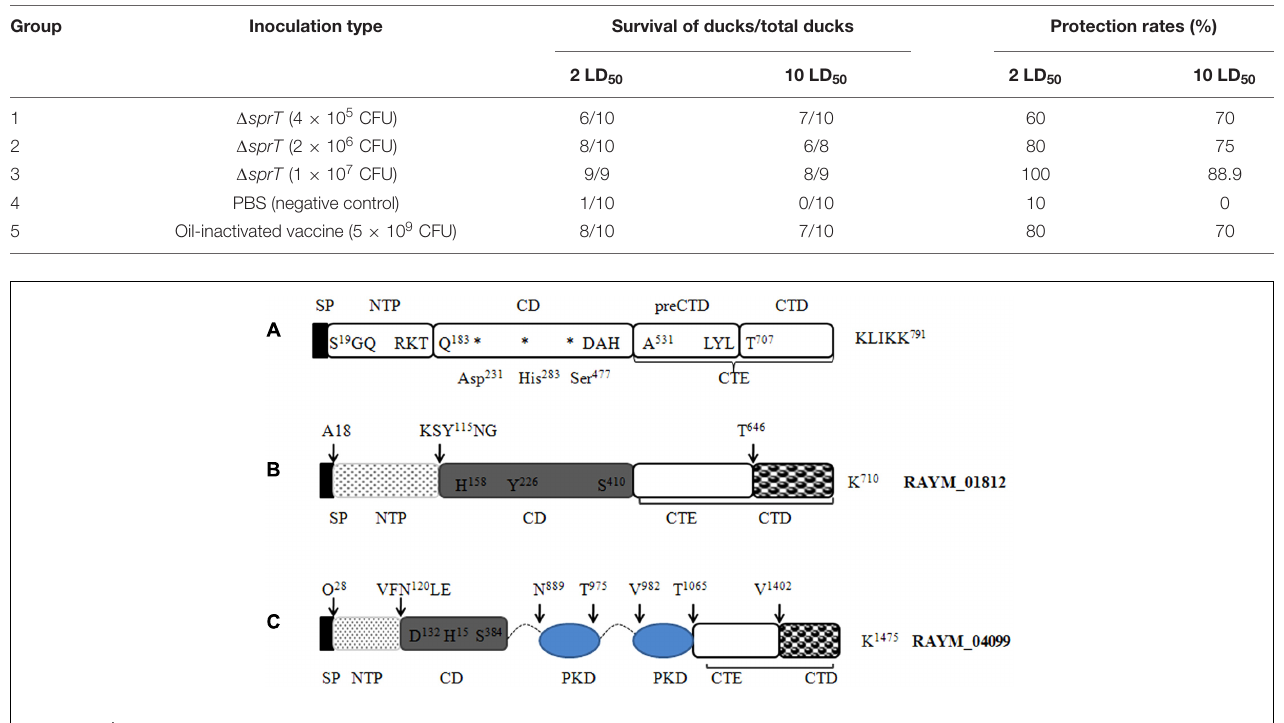
TABLE 3 | Immune effect of the mutant strain (cid:49) sprT. Group